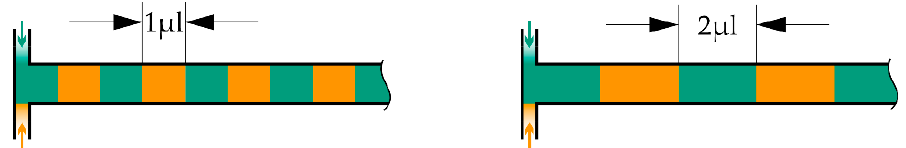
Figure 5. Visualization of different fluid packet sizes inside the microchannel. Of course, the zebra stripe pattern is for illustration purposes only and will not be present in reality due to mixing effects and diffusional transport.